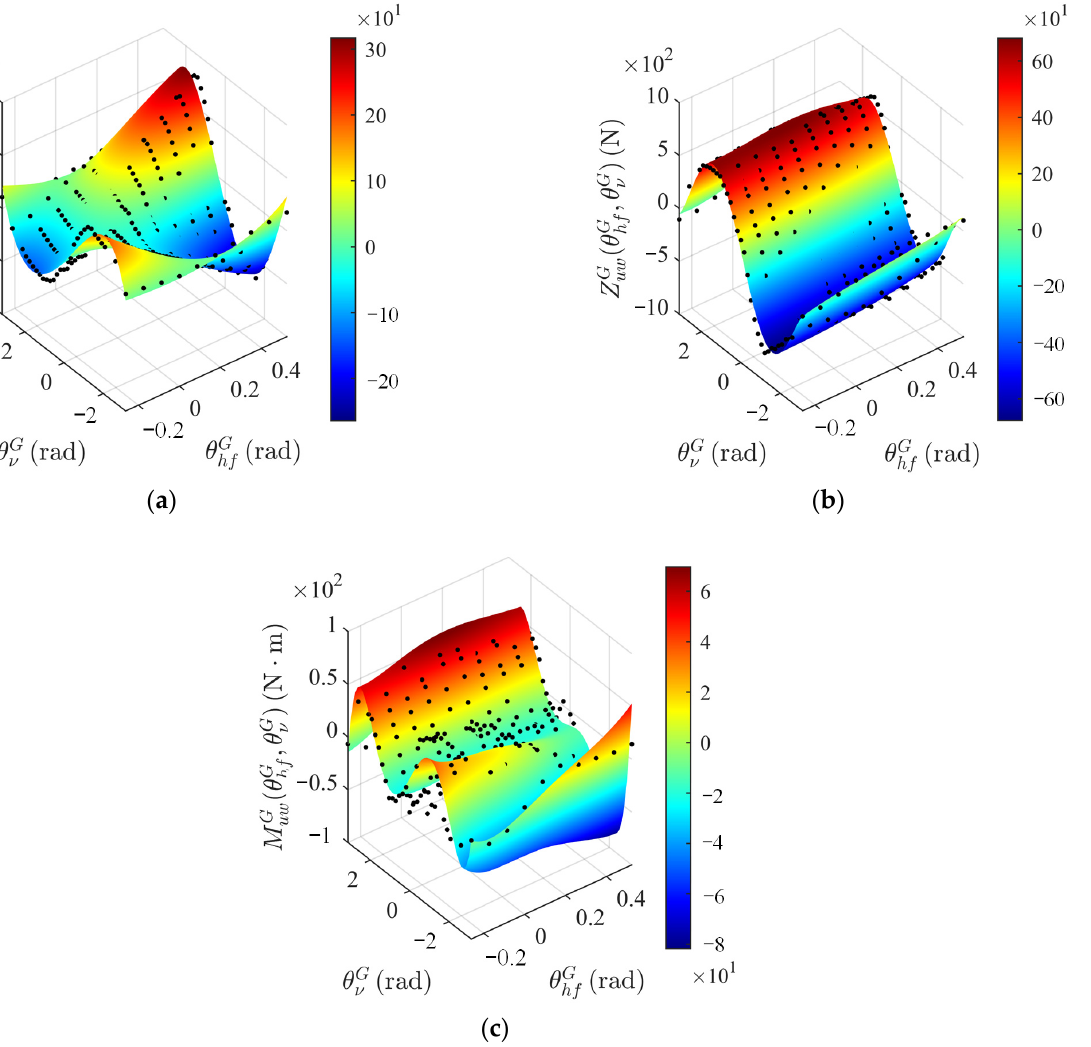
Figure 7. The simulation and fitting results of static tests: ( a ) surge force; ( b ) heave force; ( c ) pitch moment.